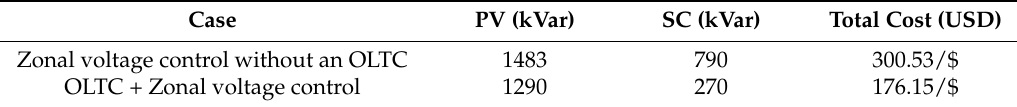
Table 2. Comparison case 1.